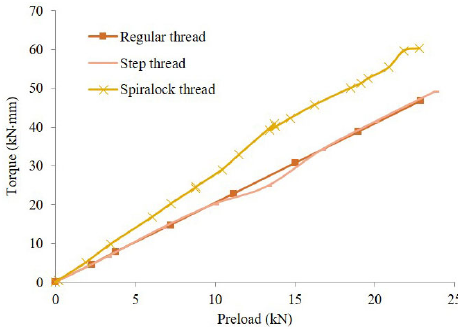
Fig. 26 Relationship curves between the input torque and preload in three types of threaded connections.